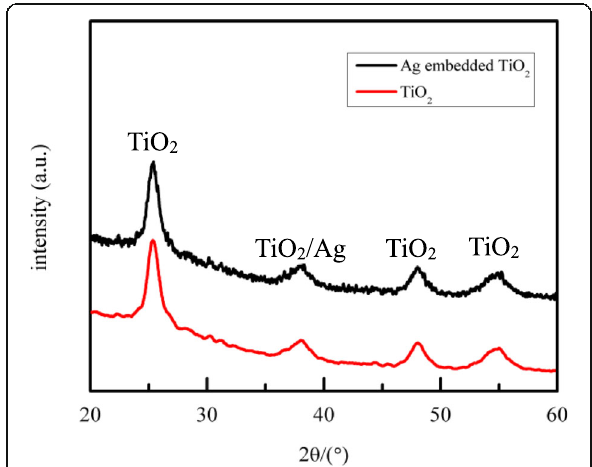
Fig. 1 XRD spectra of TiO 2 and Ag-embedded TiO 2